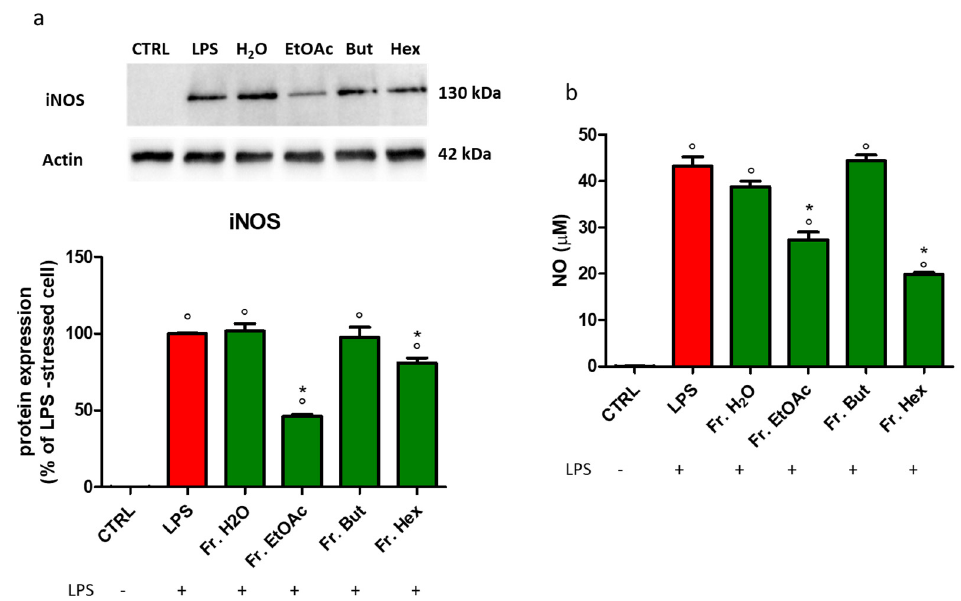
Figure 14. iNOS protein expression and NO level in BV-2 cells treated with different chestnut leaf extract fractions. BV-2 cells were treated for 3 h with 50 µ g/mL of different leaf-derived extract fractions (L Fr.), then stimulated with 0.5 μ g/mL LPS for a total of 24 h. ( a ) After cell lysis, the extracted proteins were separated by SDS-PAGE, transferred to a nitrocellulose membrane, and immunoas- sayed using anti-iNOS and anti-actin antibodies, as reported in the Materials and Methods section. Immunoblot is representative of three independent experiments; bars represent the densitometric analysis of immunoblotting results. Normalised expression levels were calculated relative to LPS-treated cells (red bars) ( b ) NO level was quantified by Griess assay as described in the Materials and Methods section. Results are expressed as means ± SEM of three independent experiments. Statisti- cal analysis was performed by Fisher’s LSD test following one-way ANOVA. ° p < 0.05 significantly different from control cells; * p < 0.05 significantly different from LPS-treated cells.